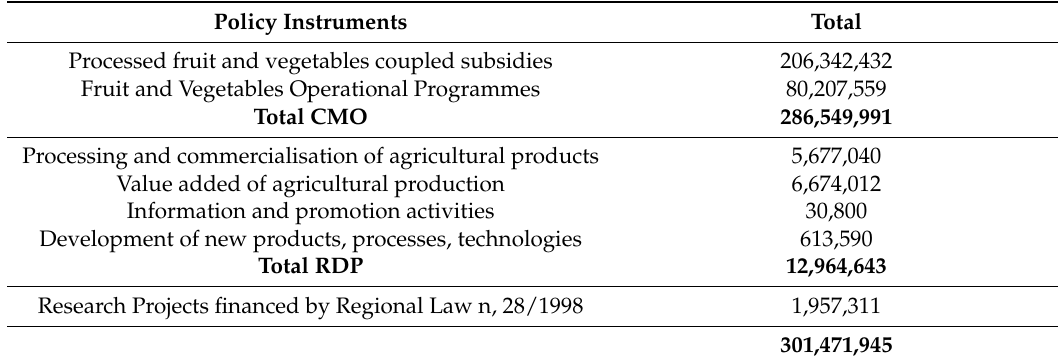
Table 5. Main resources * for the processing tomato sector (payments 2002–2015, €